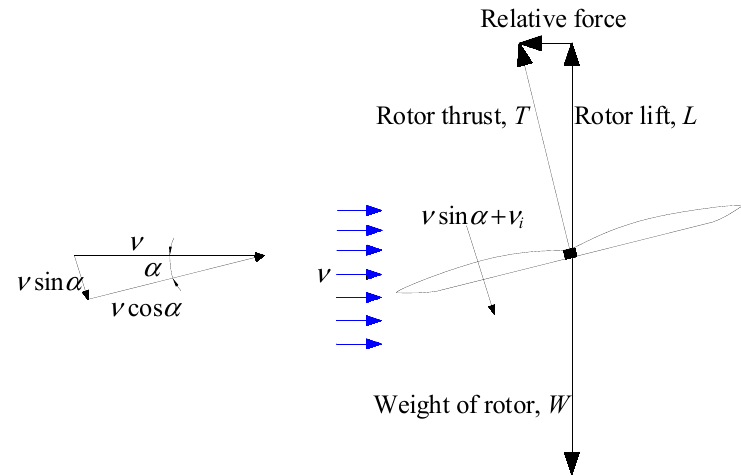
Figure 3. The airflow model of the rotor disk in the horizontal